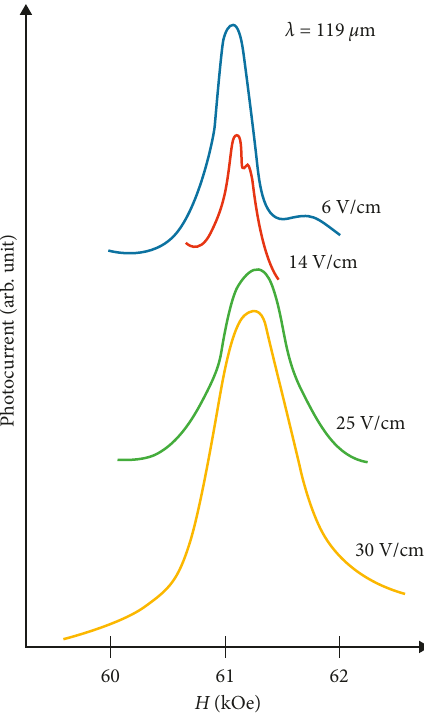
Figure 13: Shape of the cyclotron resonance lines of the sample I at T � 4 . 2 K, λ ≈ 119 μ m, ε ≈ 14V · cm − 1 , and at different electric BD fields. The measurements were done in the voltage regime far from the breakdown, and in the current regime at the